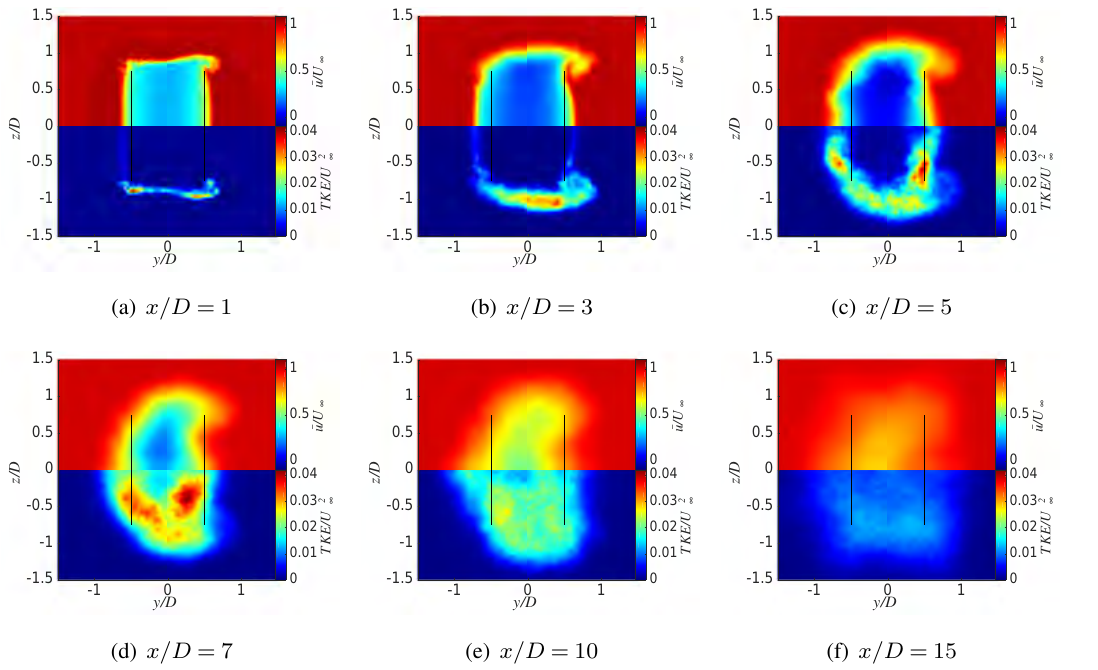
Figure 8. H-type VAWT with AR = 1 . 5: mean streamwise velocity ¯ u/U ∞ and turbulent kinetic energy ¯ k in cross-flow slices.